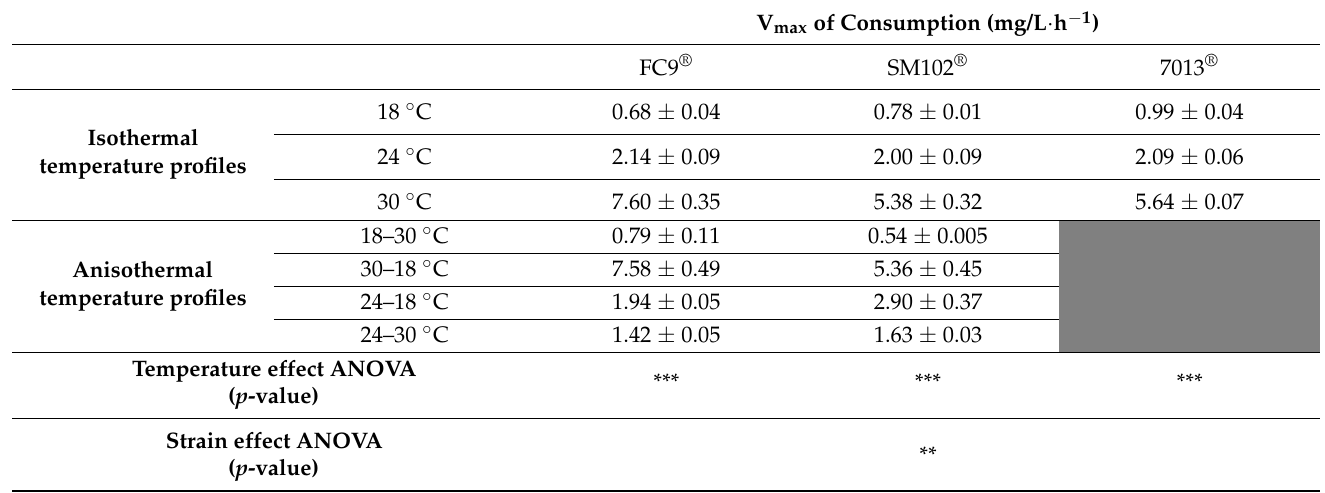
Table 2. Maximum acetaldehyde consumption rate at the beginning of the stationary phase. ANOVA statistical analysis: effects of temperature and